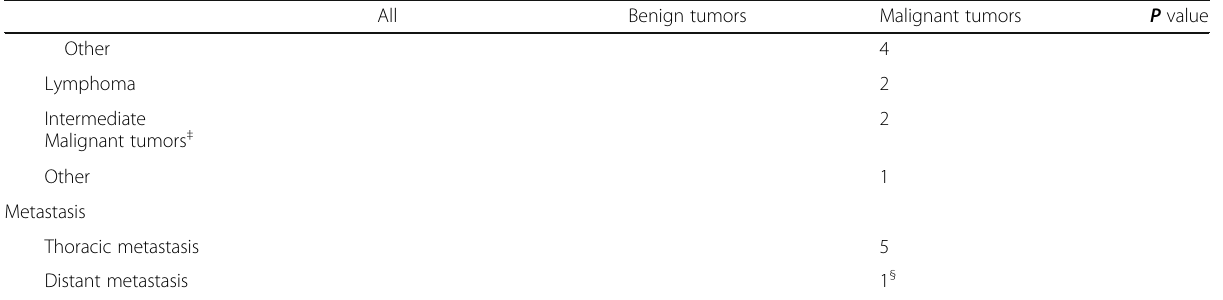
Table 1 Characteristics of patients ( n = 46) (Continued)